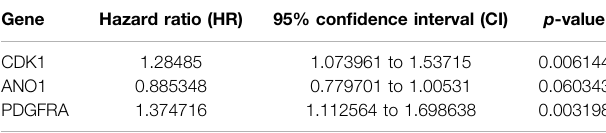
TABLE 1 | The multivariate Cox regression analysis for identi fi cation of m7g- related genes associated with prognosis in